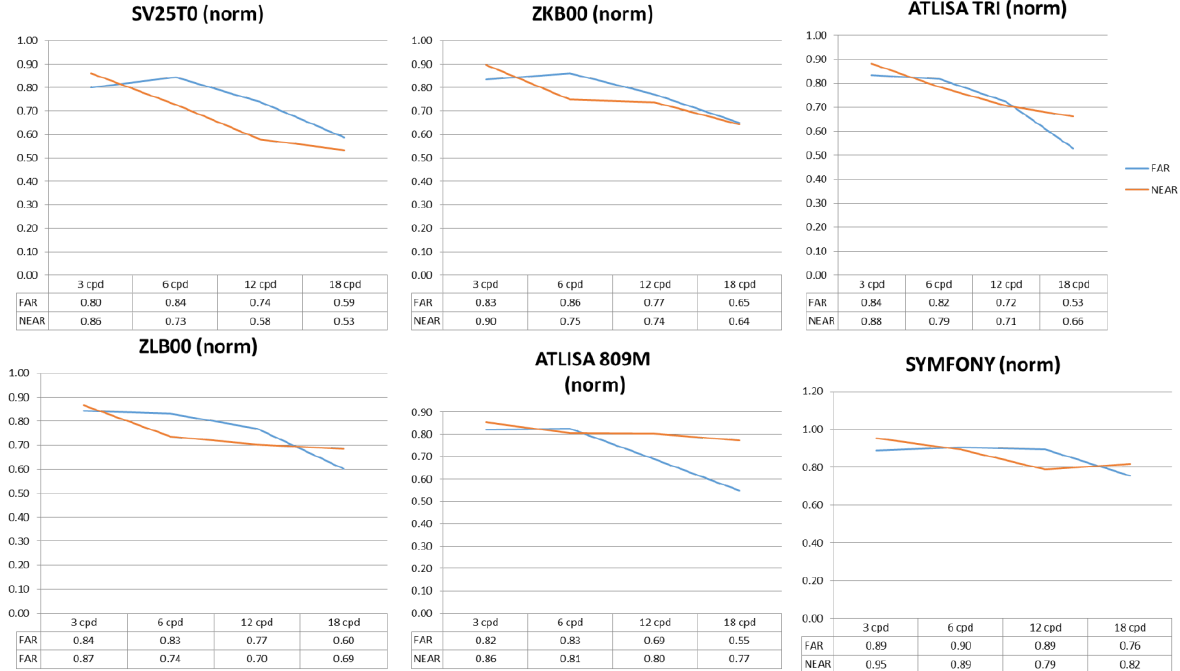
Figure 2. Postoperative binocular corrected photopic distance and near normalized contrast sensitivity (CS) values. The approach reported by Boxer Wachler and Krueger [16] was employed for data normalization.